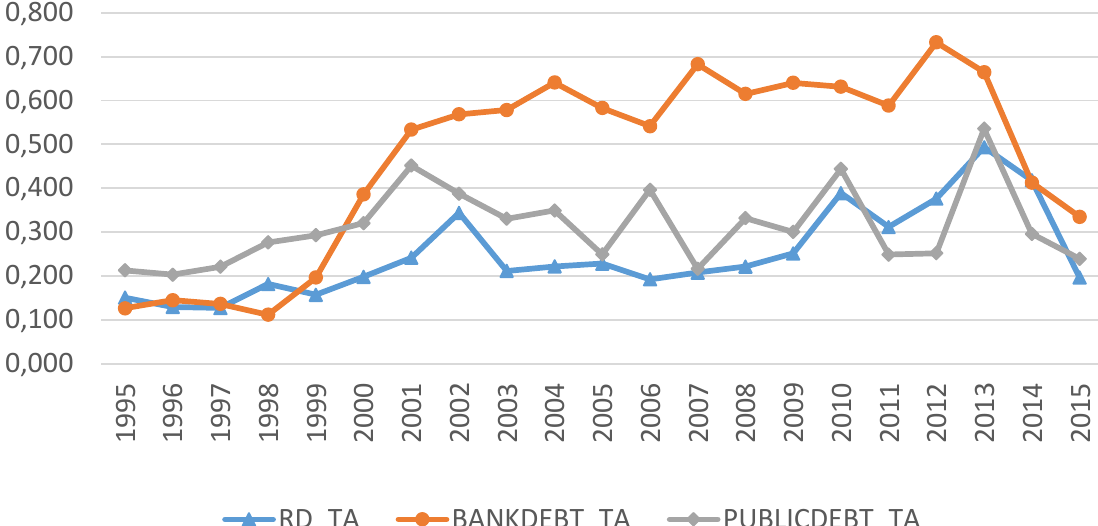
Figure 1. Relationships among R&D investment, bank debt ratio and public debt ratio over